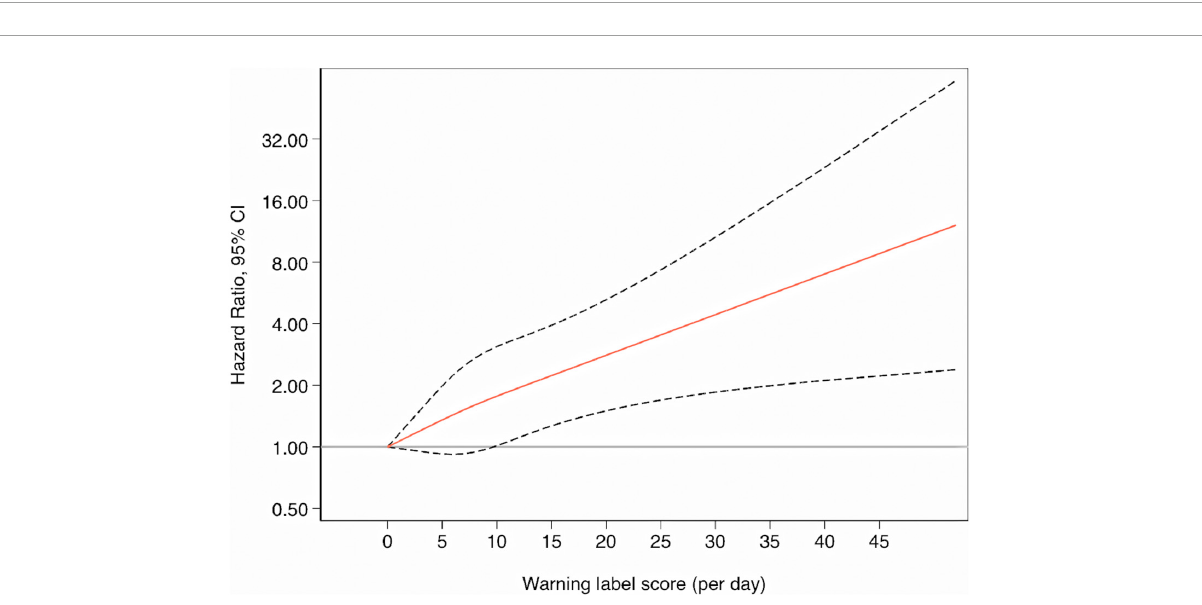
FIGURE5 The smooth line represents the hazard ratio for the risk of all-cause mortality when using zero as the reference value for the warning label score (3 knots) whereas the dashed lines indicate 95%